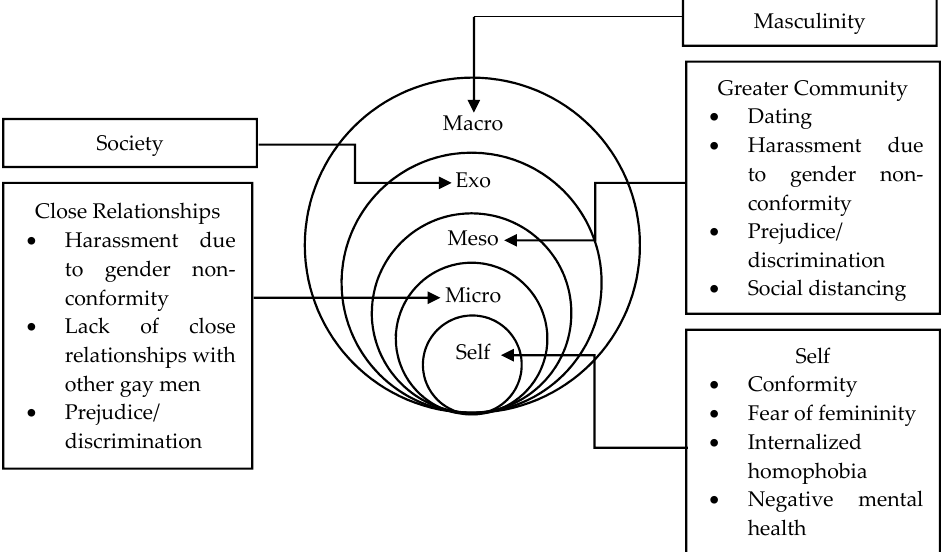
Figure 1. Socio-ecological map of a gay man.